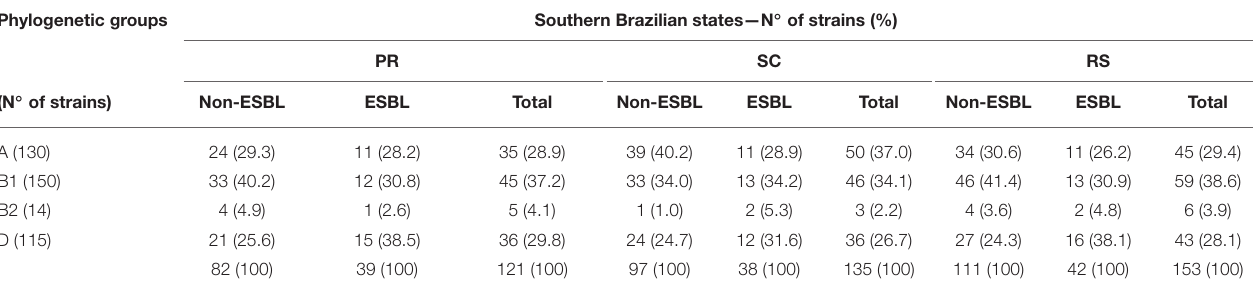
TABLE 2 | Phylogenetic distribution of 290 non-ESBL-producing E. coli strains and 119 ESBL-producing E. coli strains isolated from chicken carcasses from different southern Brazilian states. Phylogenetic